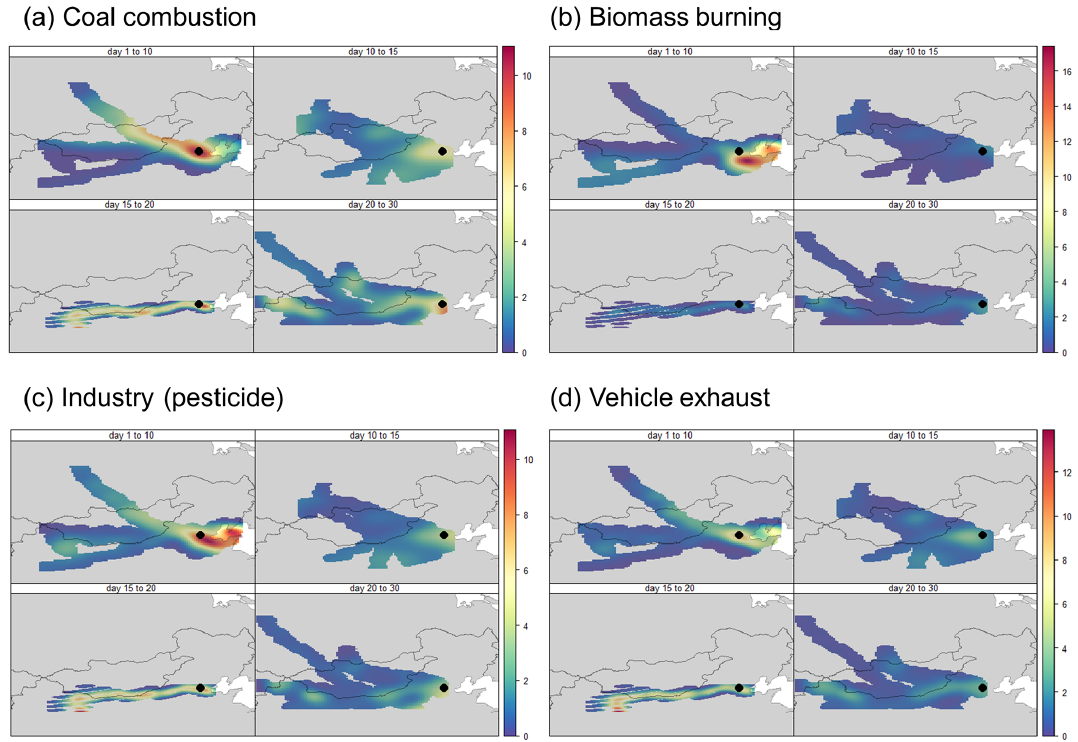
Figure 9. Concentration weighted trajectory (CWT) analysis of the sources resolved by non-negative matrix factorization (NMF), i.e., coal combustion (a) , biomass burning (b) , industry (c) , and vehicle exhaust (d)